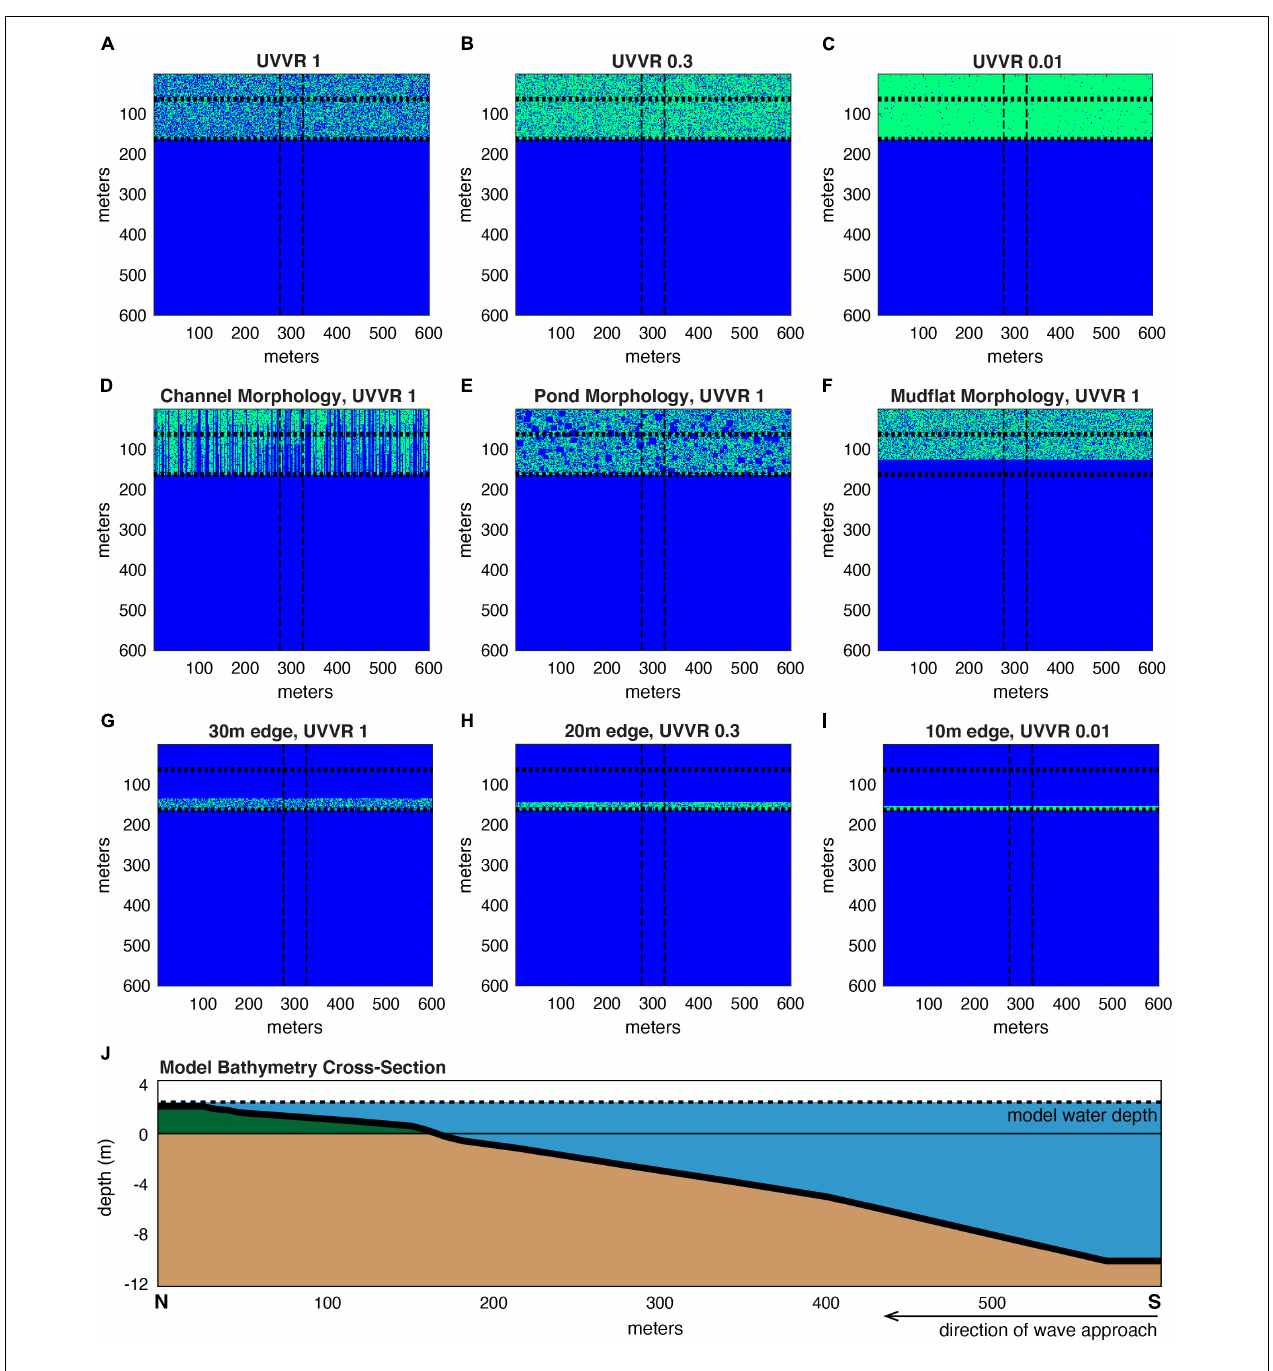
FIGURE 1 | Example 600 by 600 m, 1-m resolution model domains for the following cases: (A–C) comparing randomized vegetation percentages; (D–F) comparing different significant marsh morphologies (channel, pond, and mudflat), and (G–I) varying the width and density of a vegetated leading edge. Vegetated cells are indicated with green. Waves approach directly from the south. Wave energy is averaged horizontally over the middle 50 m, indicated with vertical dashed lines. Percent change in wave energy is determined between the horizontal dotted lines. (J) Cross-section of model input bathymetry, with model water depth indicated by the dotted line. Vegetation for all cases began at 0 m depth; indicated by